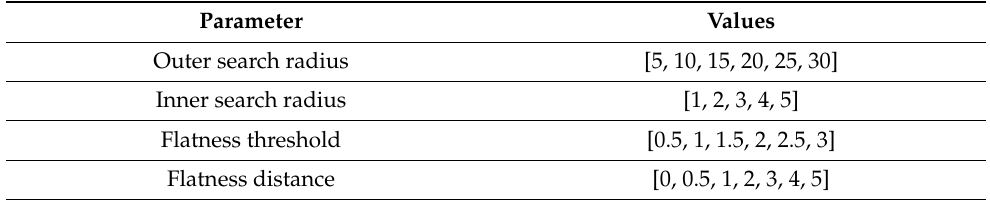
Table 2. Values of the parameters used in the generation of geomorphon classes.